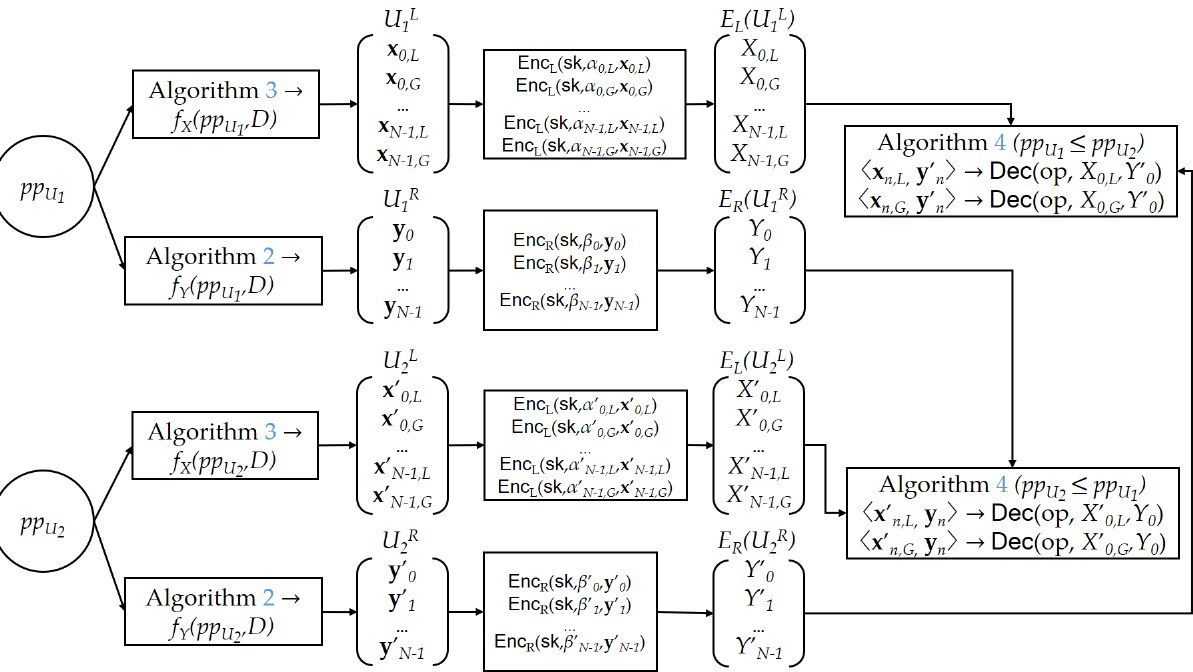
Figure 5. Comparison of encrypted bids.